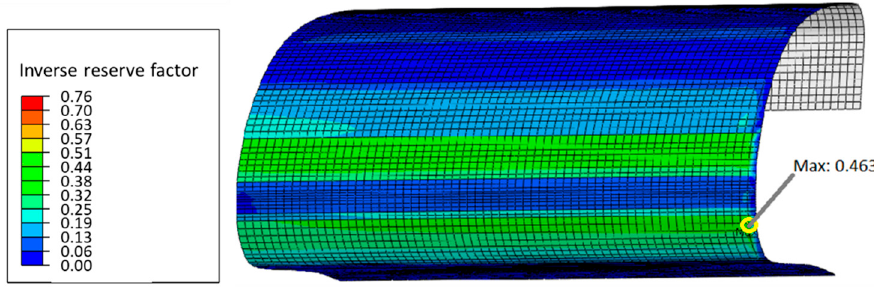
Figure 14. Distribution of inverse reserve factor in the skin of the morphing leading edge.